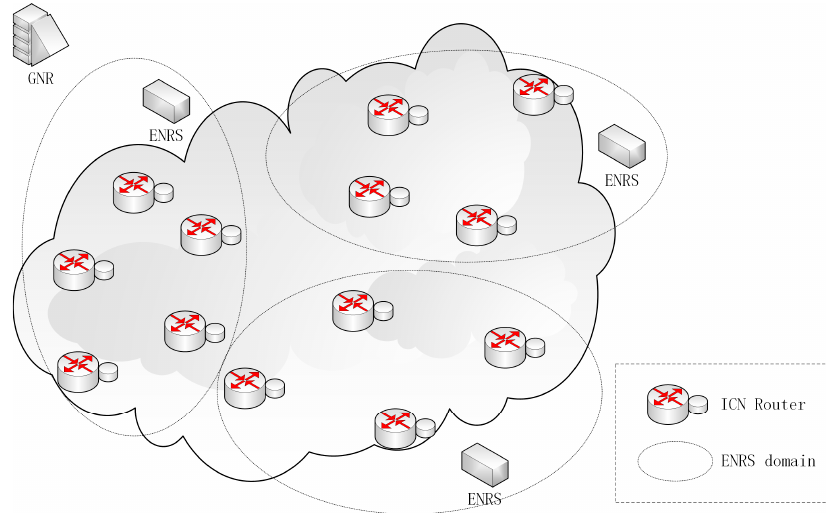
Figure 2. ENRS schematic diagram.